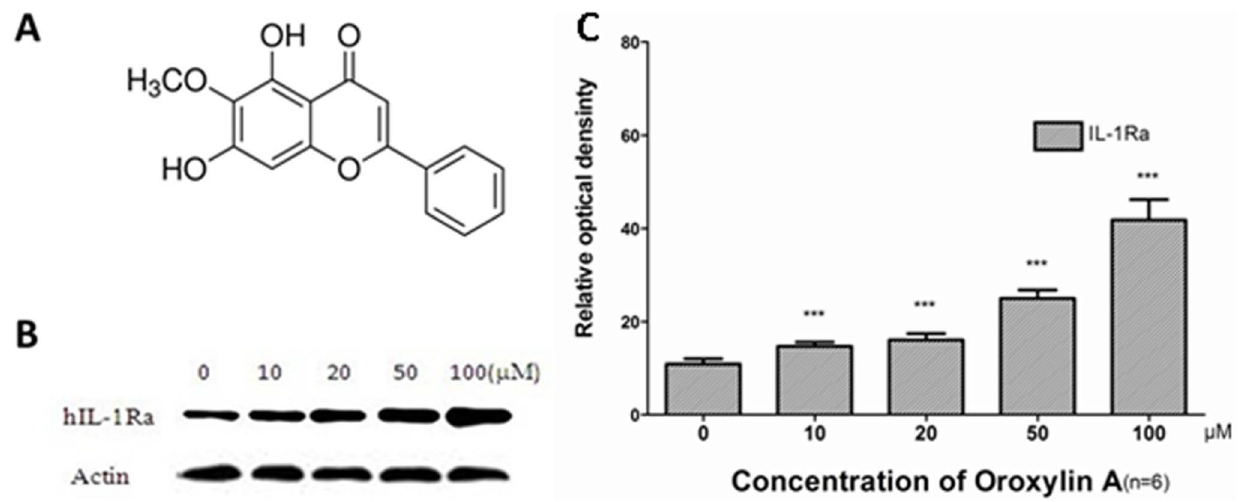
Figure 1. Oroxylin A up-regulates the production of IL-1Ra in hepG2 hepatoma cell line. (A) Molecular structure of oroxylin A (C 16 H 12 O 5 , MW: 284.). (B) Oroxylin A up-regulates the production of IL-1Ra in hepG2 hepatoma cell line (n=6). (C) Inhibitory rate of IL-1Ra protein expression.